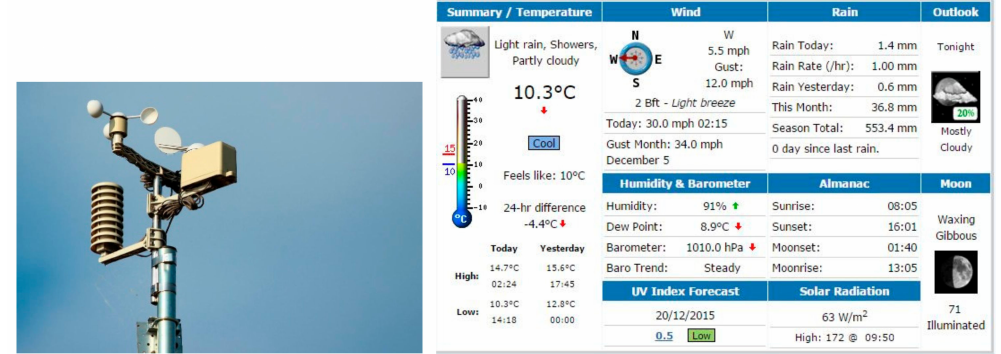
Figure 12. Typical weather sensors are sensors that measure humidity, wind speed, amount of rainfall, air pressure and temperature ( left ) [161], which can be automatically linked with IoT platform ( right )